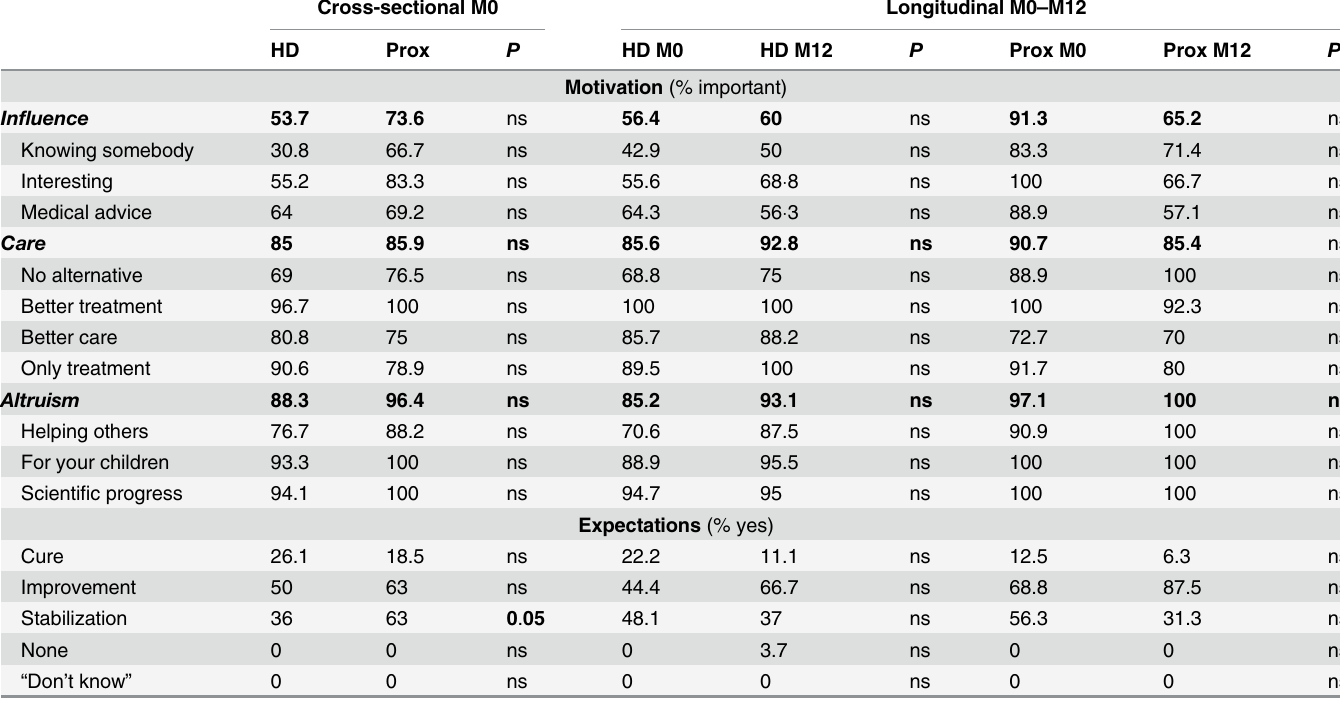
Table 2. Reasons for consenting: motivations and